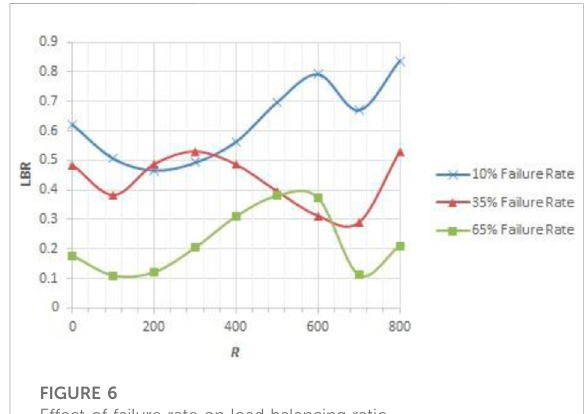
FIGURE 7 Effect of failure rate on packet delivery